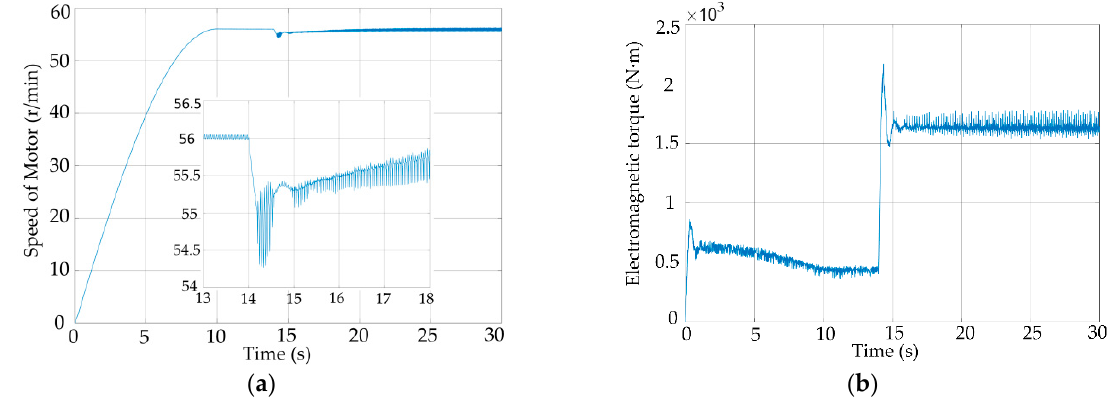
Figure 19. The curve of motor speed and electromagnetic torque of traditional belt conveyor. ( a ) Speed curve; ( b ) Electromagnetic torque curve.